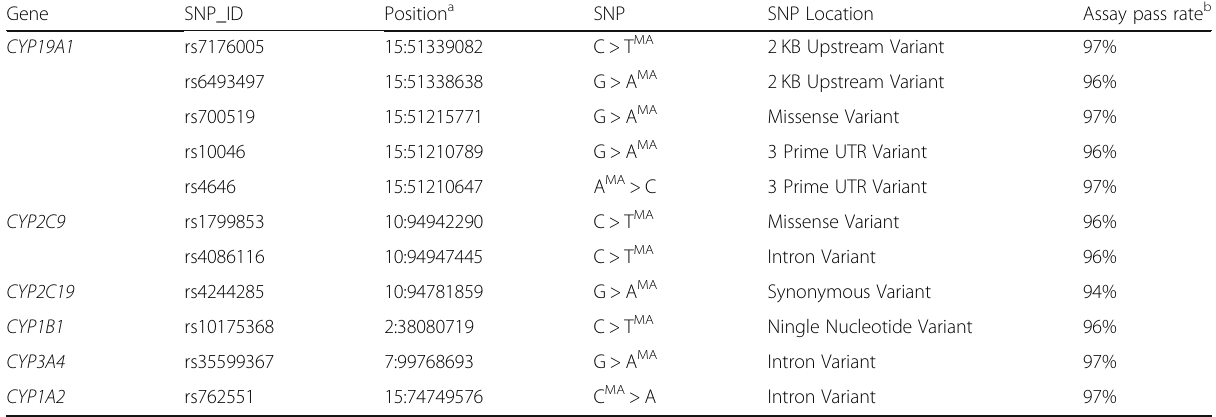
Table 1 List of genes, their SNPs, positions, and genotyping data based on the whole cohort ( N = 449) Gene SNP_ID